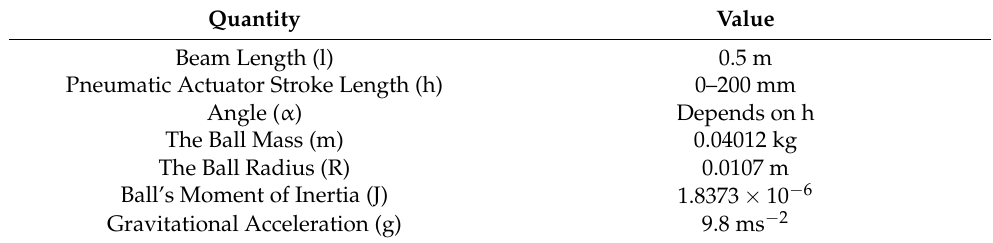
Table 2. IPABB system parameters.